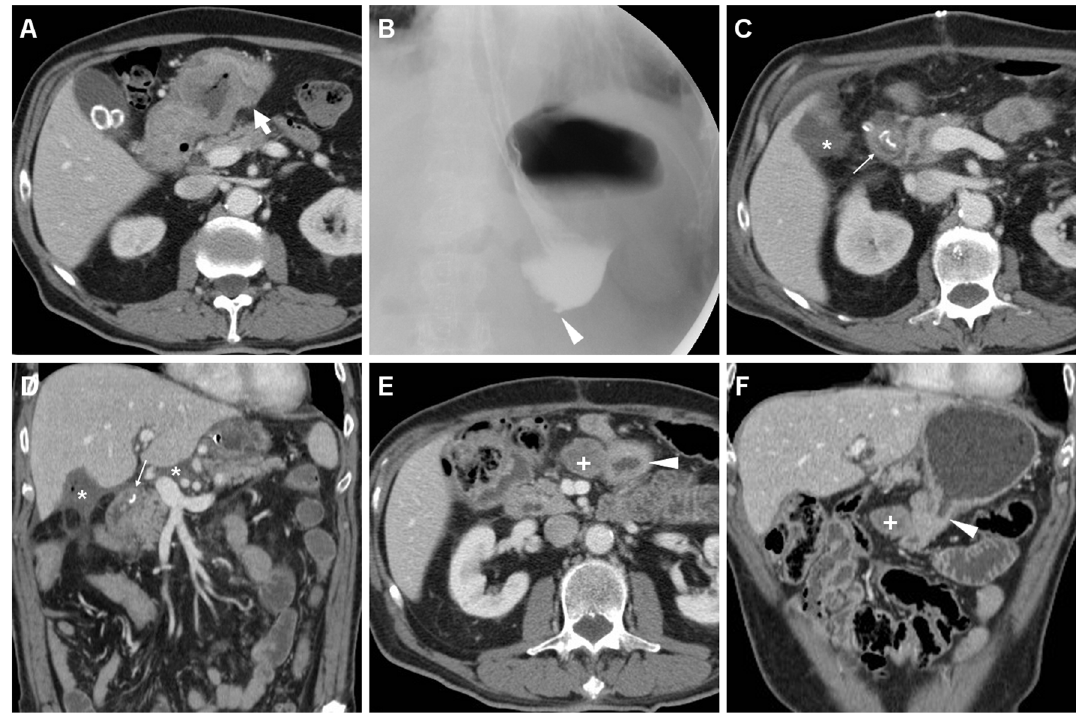
Fig. 7 A 76-year-old male with stricturing antro-pyloric carcinoma (thick arrow) as preoperatively depicted by CT (A) underwent subtotal gastrectomy with Roux-en-Y reconstruction. Early postoperative CF (B) showed little or no transit through the GJS (arrowhead). On 8th POD during postoperative sepsis,contrast-enhancedCT(C,D)showednormalstapledDS(thinarrows),